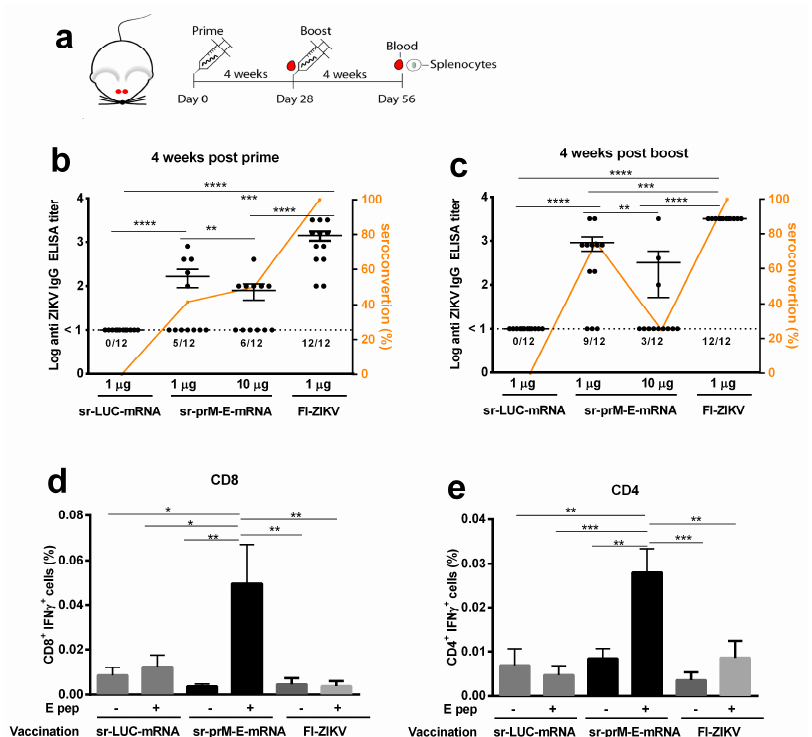
Figure 2. Immunogenicity of the sr-prM-E-mRNA and FI-ZIKV vaccines in BALB / c mice. ( a ) Mice were intradermally electroporated on day 0 and 28 with either 1 or 10 µ g of sr-prM-E-mRNA ZIKV vaccine, 1 µ g of FI-ZIKV vaccine, or with 1 µ g sr-LUC-mRNA. Antibody titers were determined four weeks after the prime ( b ) or boost ( c ) by a ZIKV E protein-specific IgG ELISA ( n = 12 in each group). The dashed lines indicate the limit of detection of the assay. The lower panels depict ZIKV E protein-specific CD8 + ( d ) and CD4 + ( e ) T cell responses in mice vaccinated with 1 µ g of sr-prM-E mRNA vaccine ( n = 5 in each group). Mice vaccinated with either 1 µ g sr-LUC-mRNA served as negative controls ( n = 5). T cell responses were determined four weeks after the boost by intracellular staining of IFN- γ in T cells stimulated with a ZIKV E protein peptide pool (E pep + ). Mice receiving only alum adjuvant served as controls for the FI-ZIKV vaccinated mice. These mice did not develop ZIKV E protein-specific antibodies or cellular immune responses, as observed for the sr-LUC-mRNA control mice (data not shown). Data are represented as mean ± SEM and were analyzed by ANOVA followed by Tukey’s test.